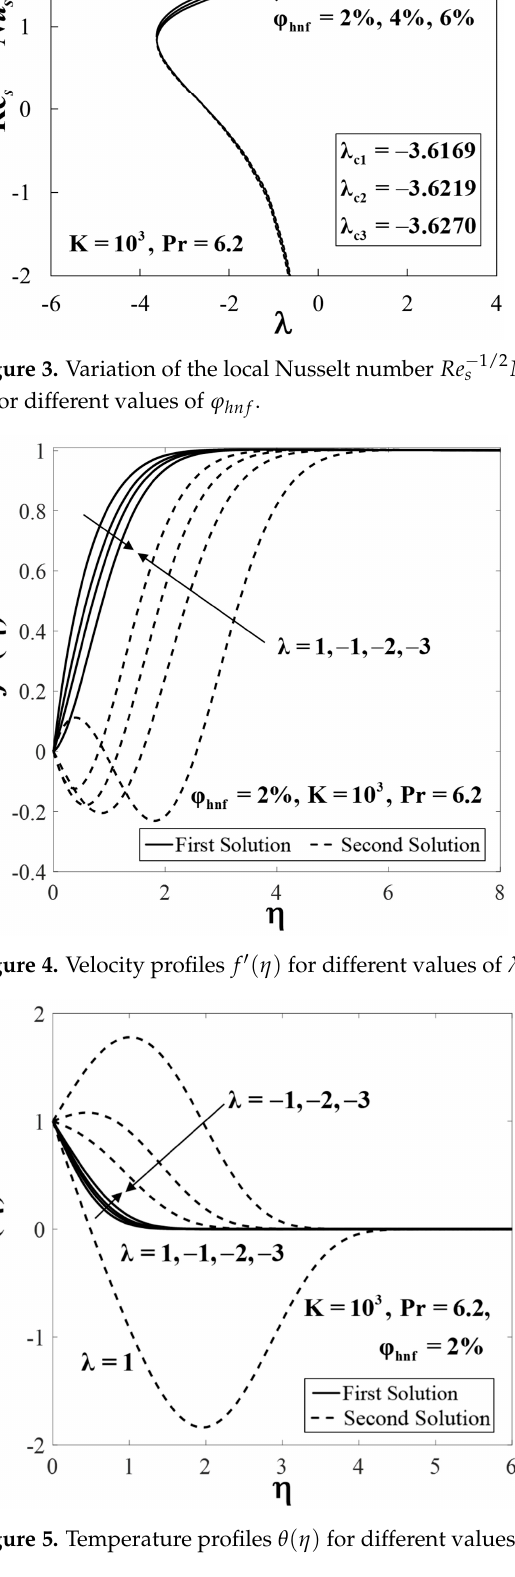
Figure 6. Velocity profiles 𝑓′(𝜂) for different values of 𝜑 (cid:3035)(cid:3041)(cid:3033) .